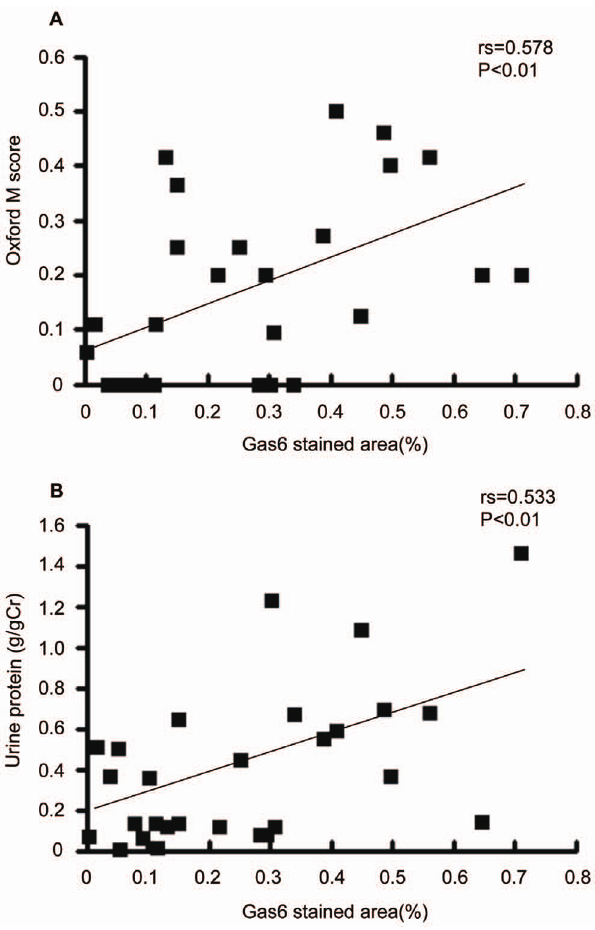
Figure 3. Correlation of Gas6 stained area with prognostic factors. Gas6 stained area in human IgA nephropathy correlated with (A) Oxford mesangial hypercellularity score and (B) urine protein excretion. N=28. Oxford M score, Oxford mesangial hypercellularity score.